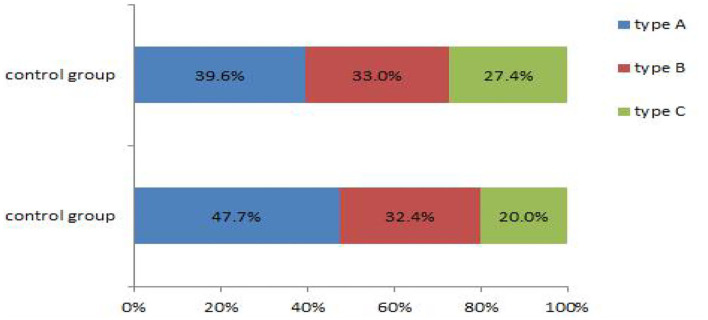
More positive blood flow was seen in the TCM experimental group.